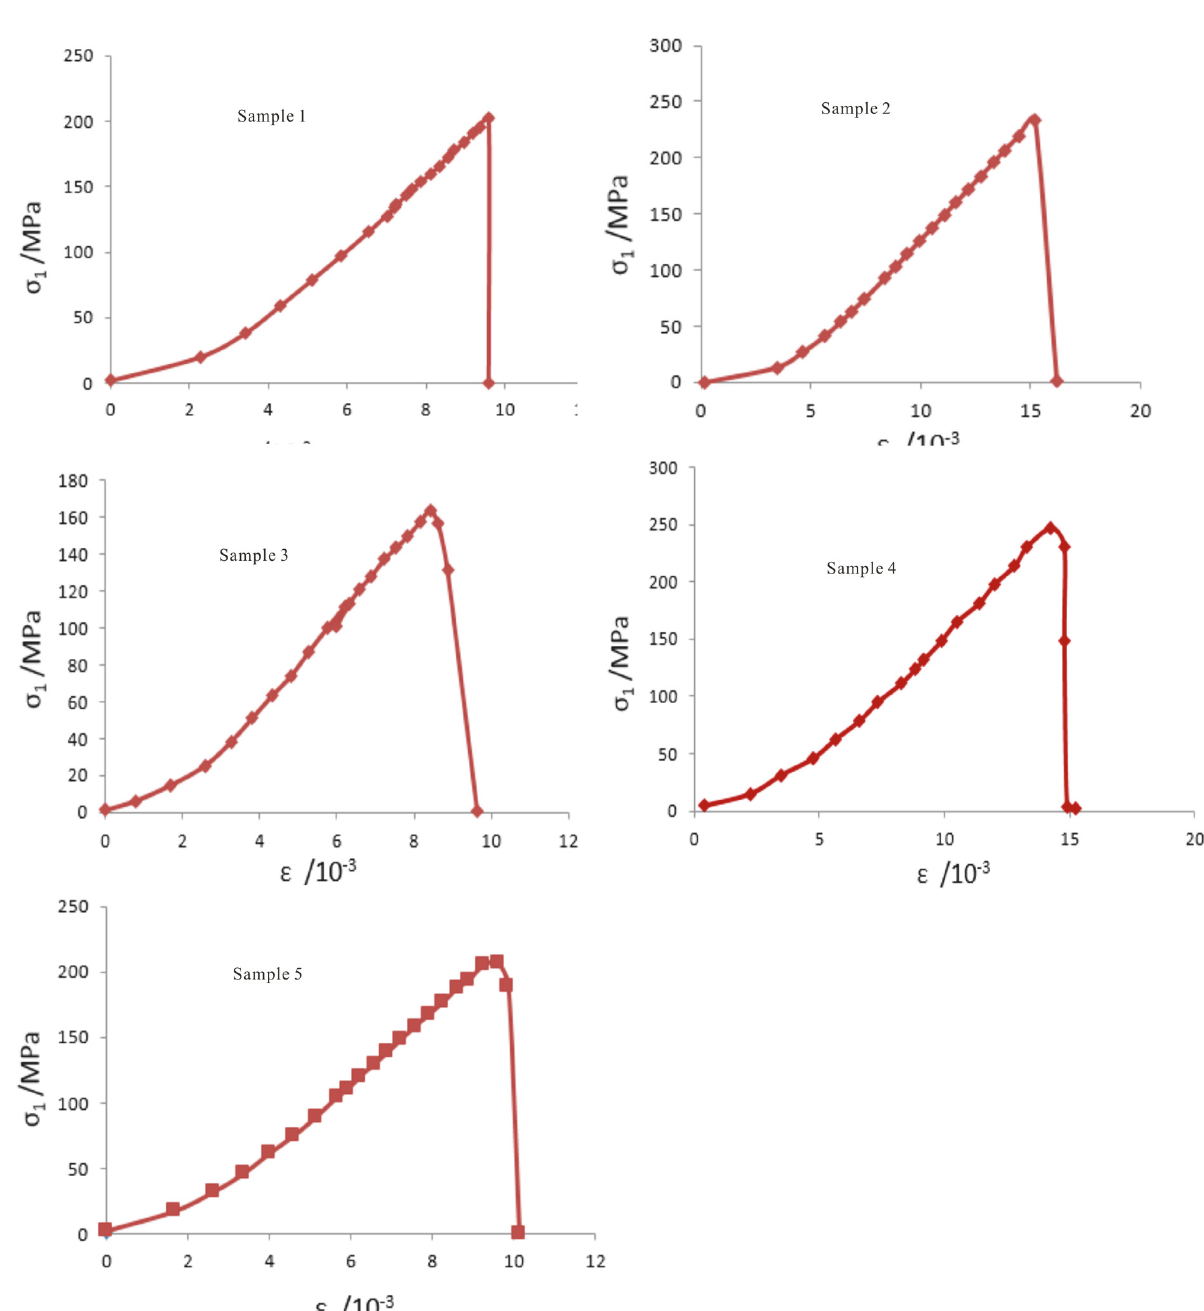
Figure 4: Stress-strain curve of